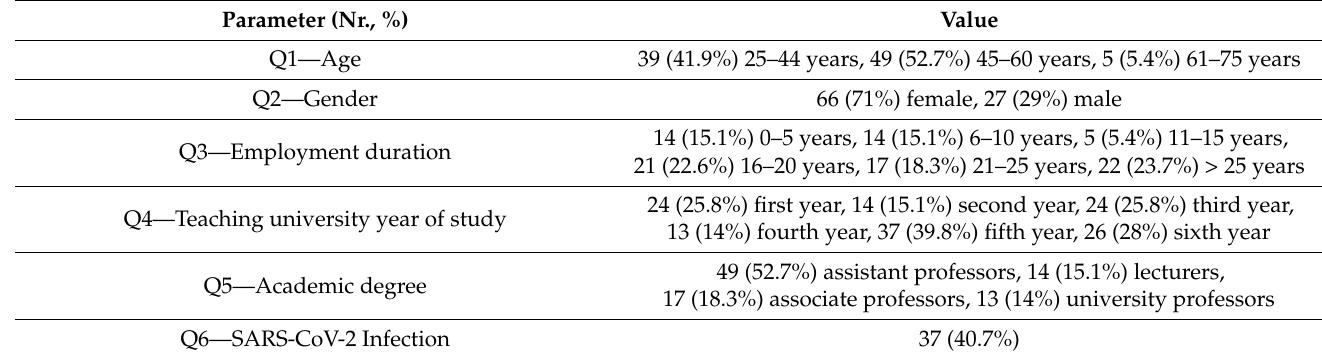
Table 1. Demographic characteristics of the university teachers.